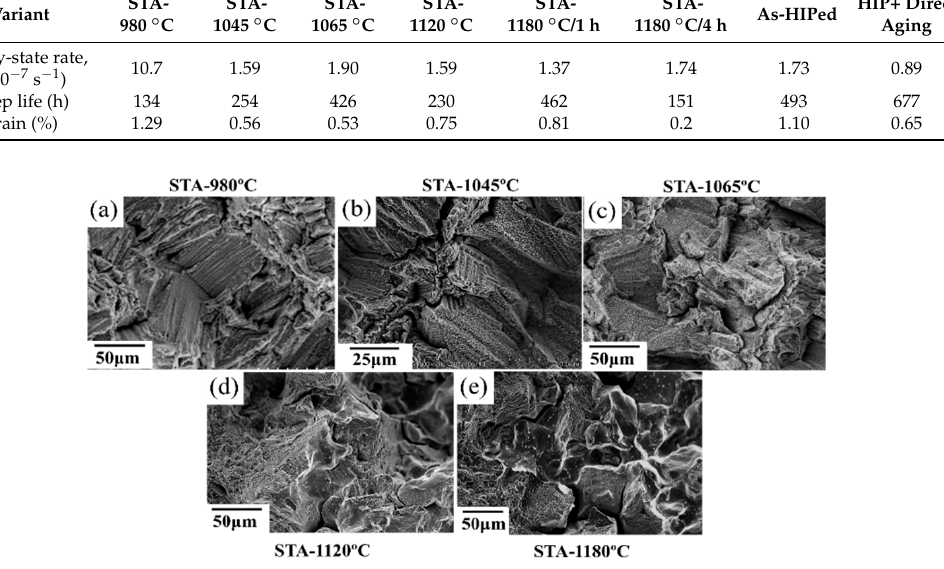
Figure 11. Rupture surfaces of ( a ) STA-980 °C specimen, ( b ) STA-1045 °C specimen, ( c ) STA-1065 °C specimen, ( d ) STA-1120 °C specimen, and ( e ) STA-1180 °C/1 h specimen under 550 MPa at 650 °C.